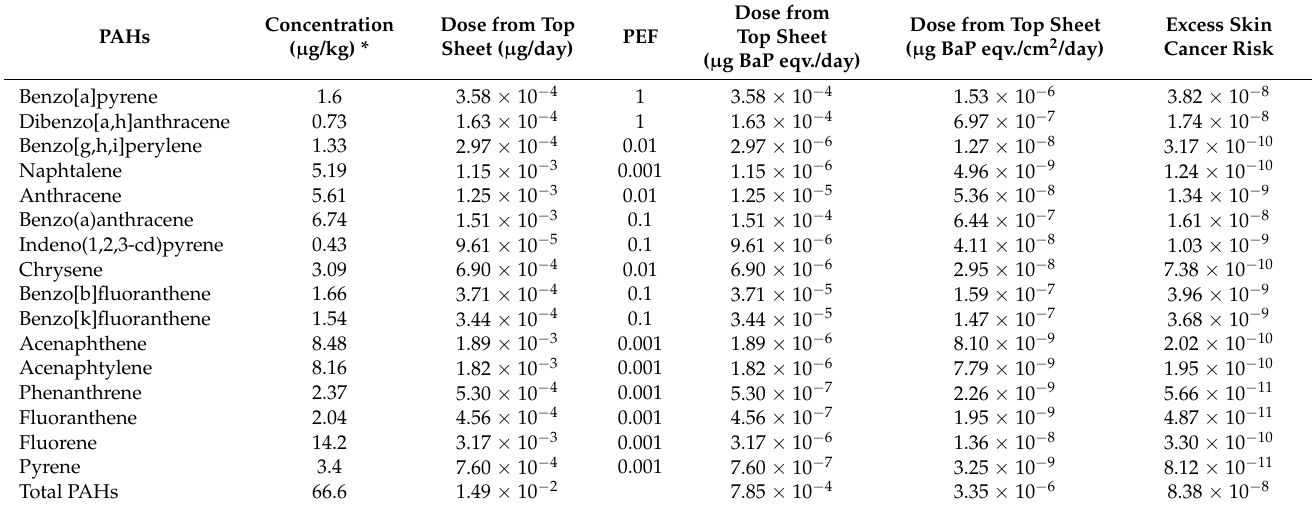
Table 4. Excess skin cancer risks of polycyclic aromatic hydrocarbons (PAHs) in the top sheet of diapers.